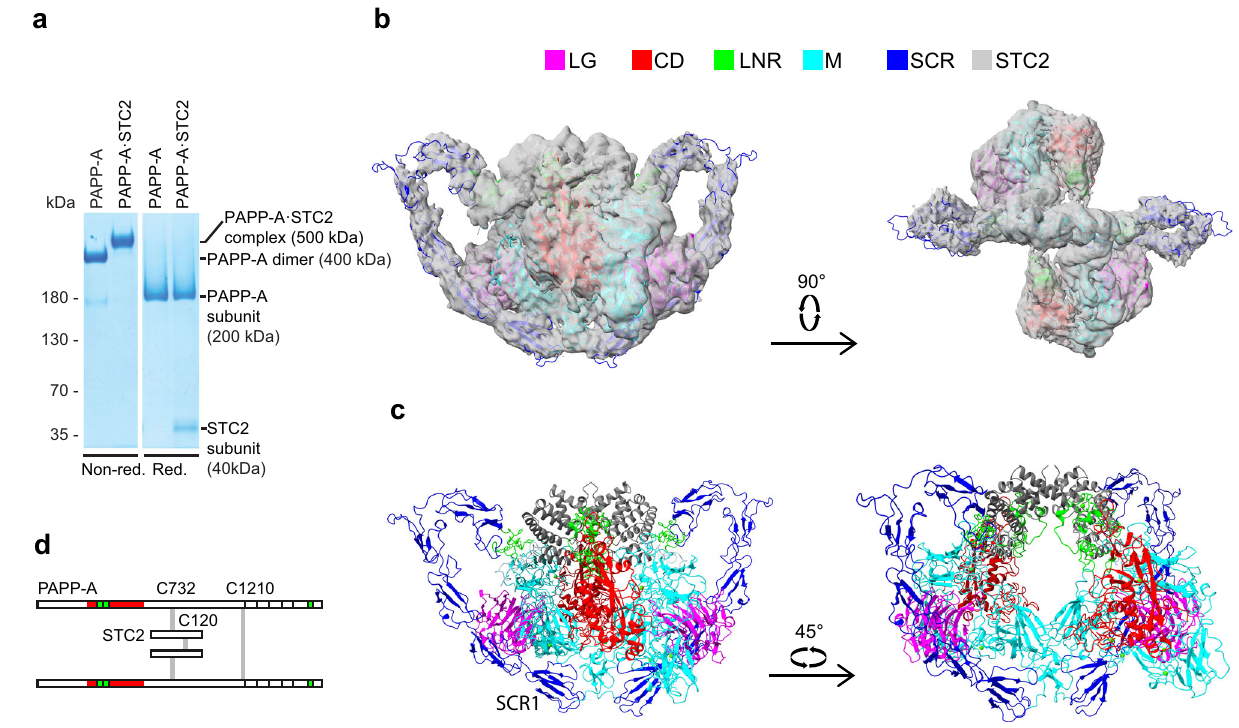
Fig. 2 | The three-dimensional structure of the human PAPP-A·STC2 complex. a SDS-PAGE separation of puri fi ed PAPP-A dimer and PAPP-A·STC2 complex used for cryo-EM analysis. Samples were reduced or non-reduced, as indicated, and the gel was stained with Coomassie brilliant blue. Active site-inactivated PAPP-A (E563Q) was used for this experiment and for further structural studies. The experimentwasrepeated>10timeswithsimilarresults.Sourcedataareprovidedas a Source data fi le. b The experimental volume isshown with the fi nal model of the